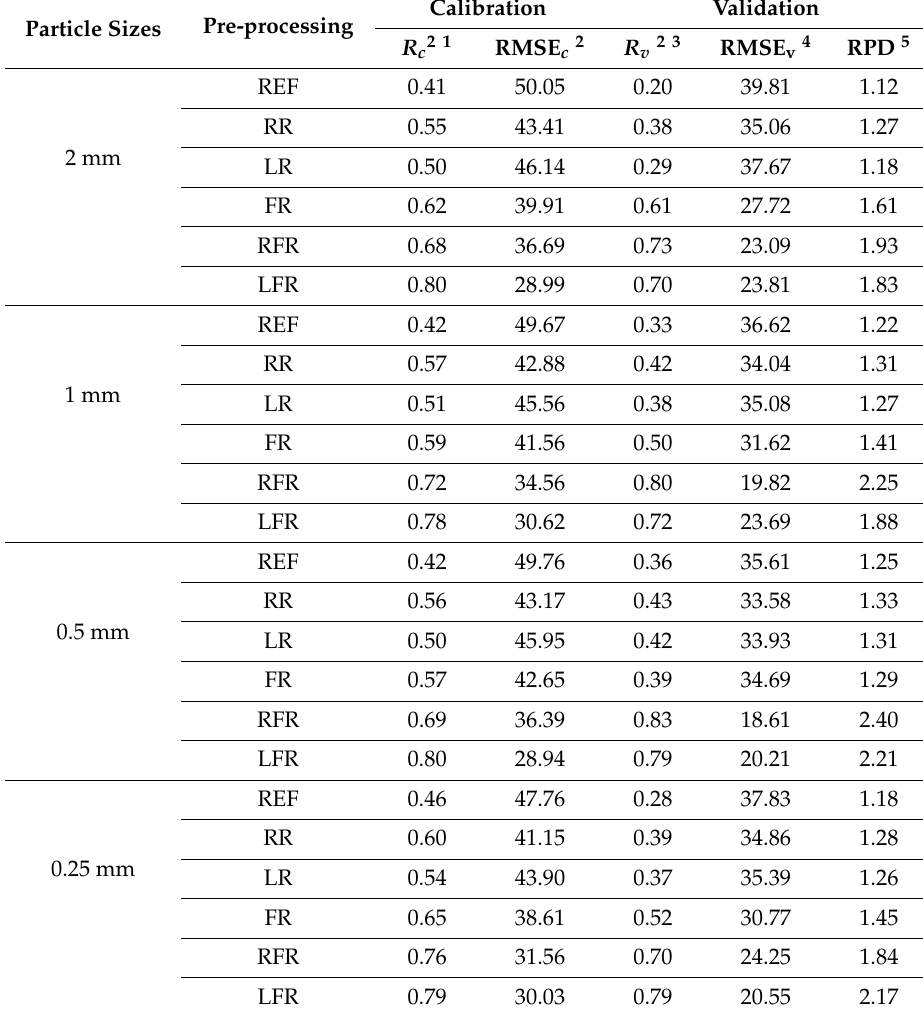
Table 3. Modeling results of simple linear regression (SLR) for SOM content. Particle Sizes